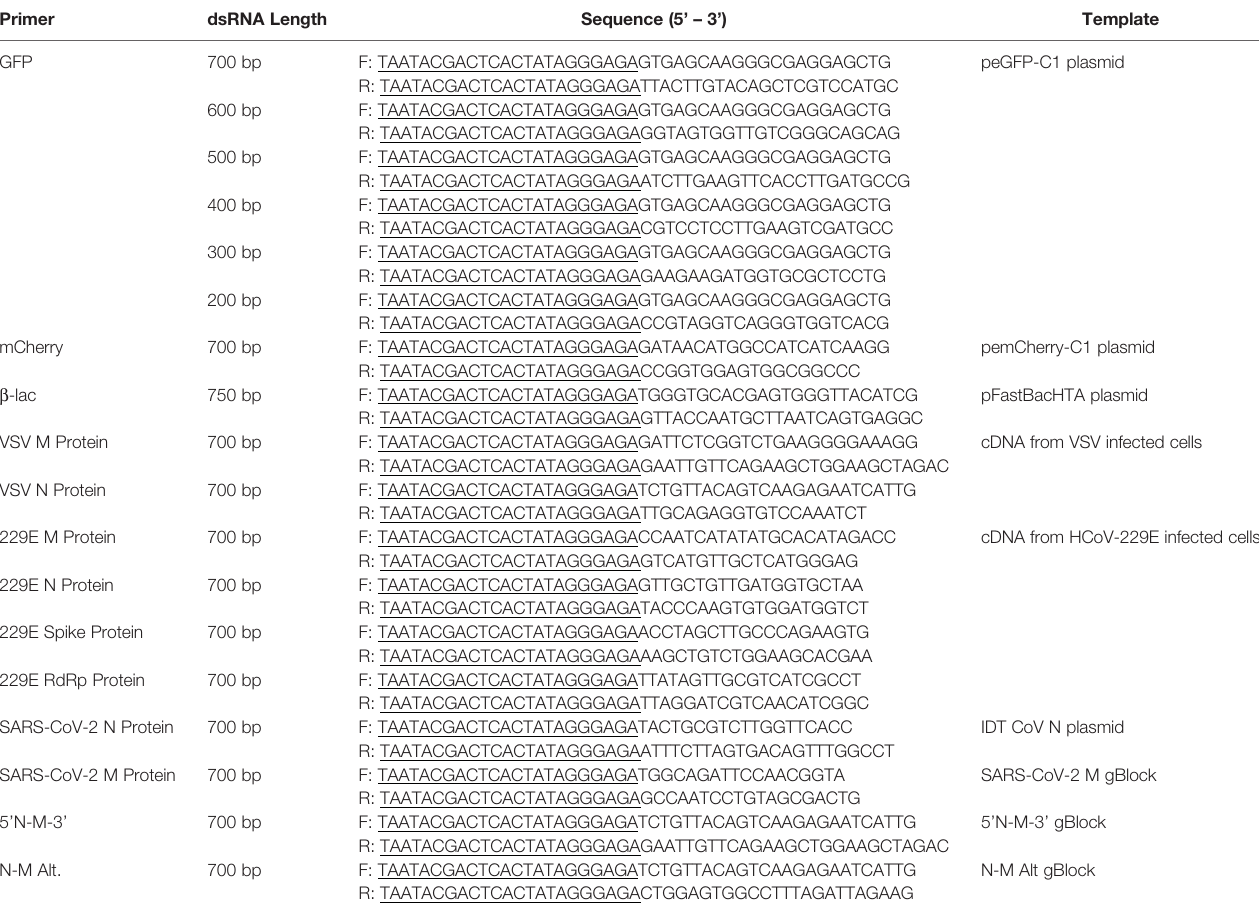
TABLE 1 | Primers with underlined T7 promoter sequences that were used for ampli fi cation of genes of interest for dsRNAi. Primer dsRNA